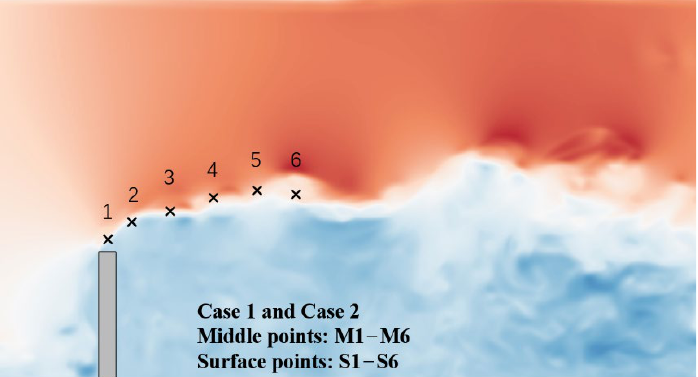
Figure 7. Top view of the position of the measurement points in Case 1 and Case 2. In the figure, 1–6 represent the plane location of six points per water layer where velocity time signals were captured, with the coordinates of the sampling points being the same in Case 1 and Case 2, M1–M6 represent the sampling point in the middle layer of the water body, and S1–S6 represent the sampling point in the surface layer of the water body.